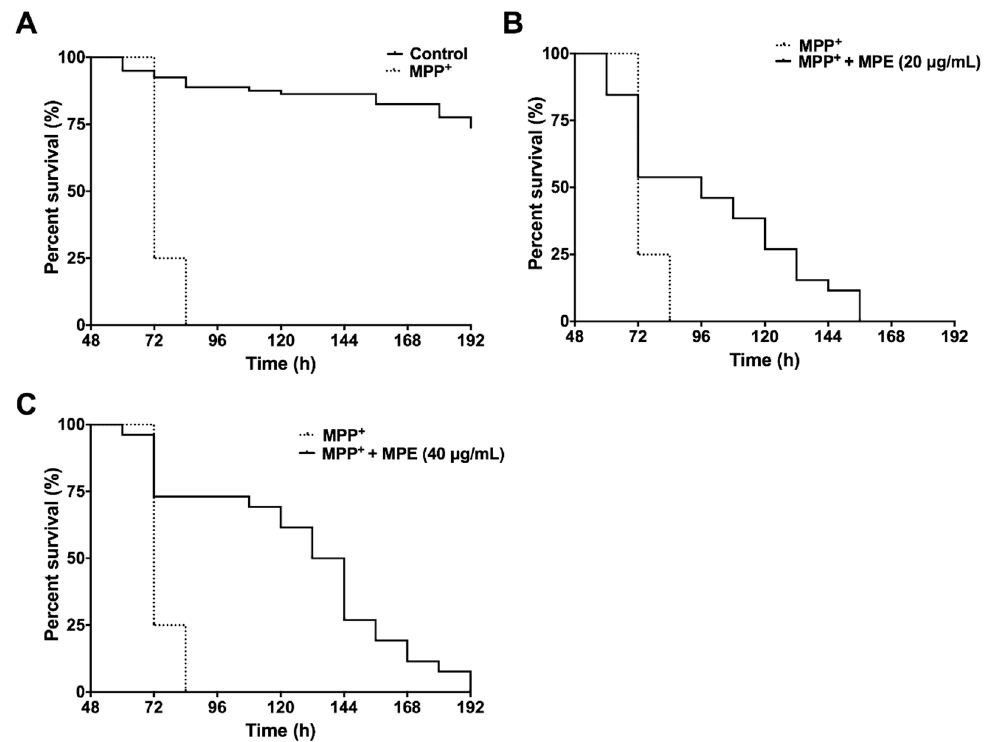
Figure 4. Effects of MPE (20 and 40 μ g/mL) on lifespan of C. elegans after MPP + exposure. MPP + at concentration of 750 μ M reduces C. elegans lifespan, as compared with control group ( A ). MPE at concentrations 20 μ g/mL ( B ) and 40 μ g/mL ( C ) increase C. elegans lifespan, as compared with toxic MPP + exposure (750 μ M). Survival curves of C. elegans were statistically analyzed by log rank test (Mantel Cox), as compared with MPP + treatment ( n > 100).